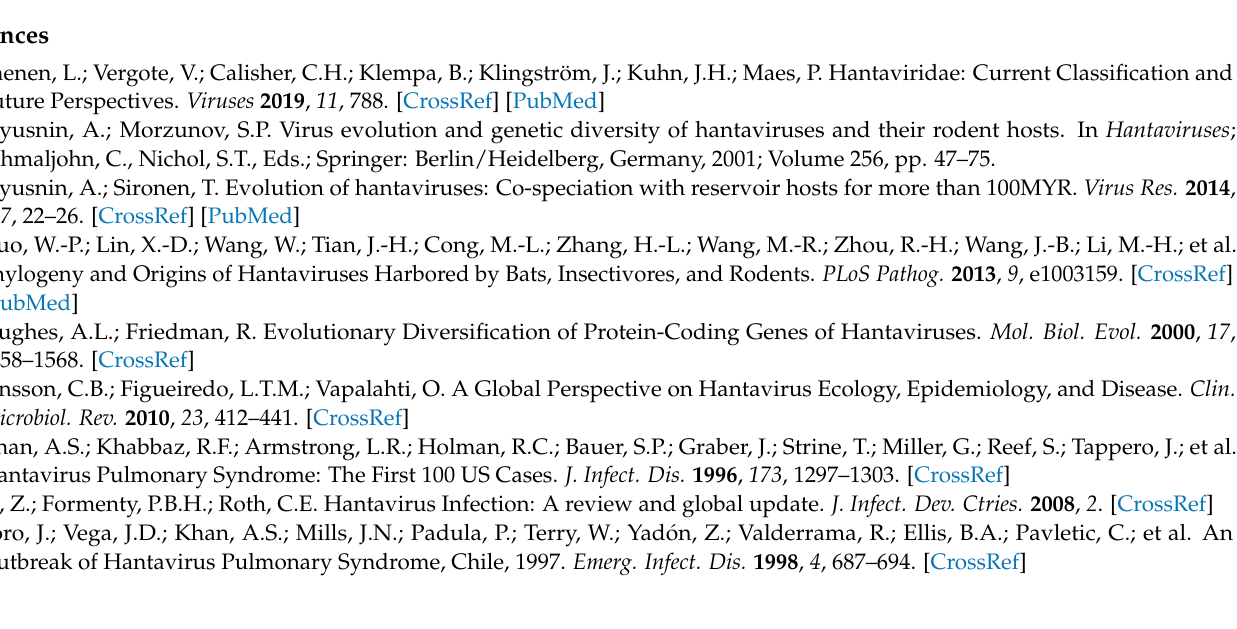
Table S3: Hylaeamys megacephalus abundance, Table S4: Oligoryzomys nigripes